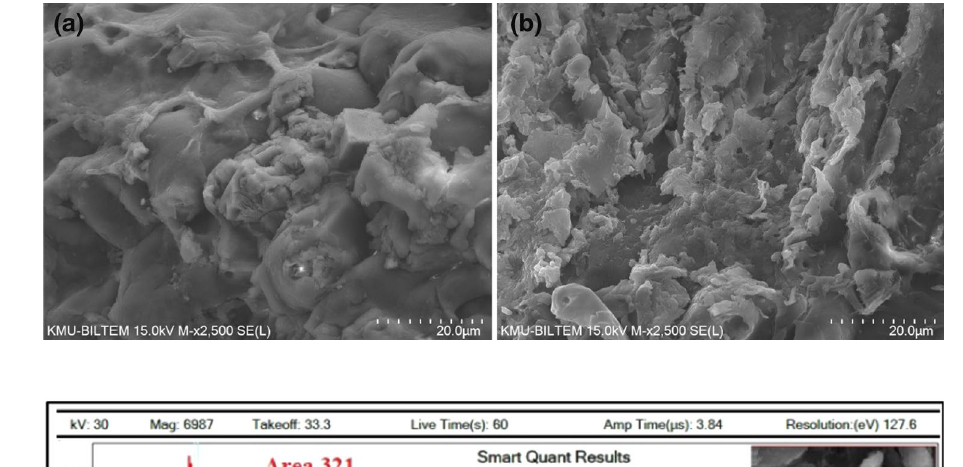
Fig. 6 EDX spectrum of P raw: a Area 321, b Area